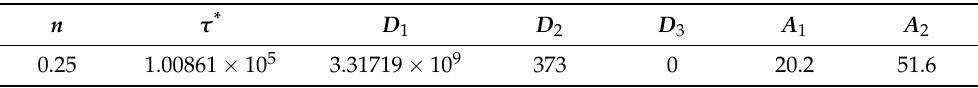
Table 7. Co-efficient values for the cross-WLF